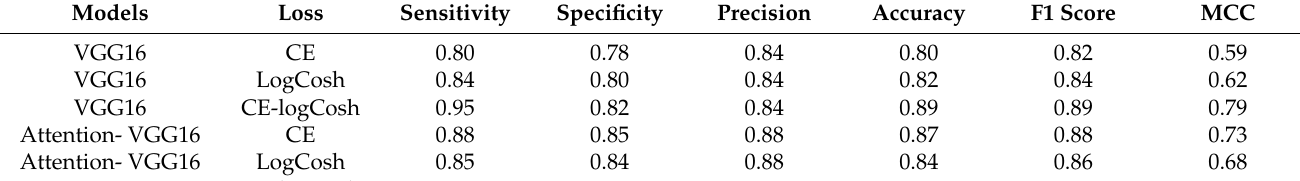
Table 1. The comparison of the vgg16 and attention-vgg16 models with different loss functions in classification of benign and malignant lesions.